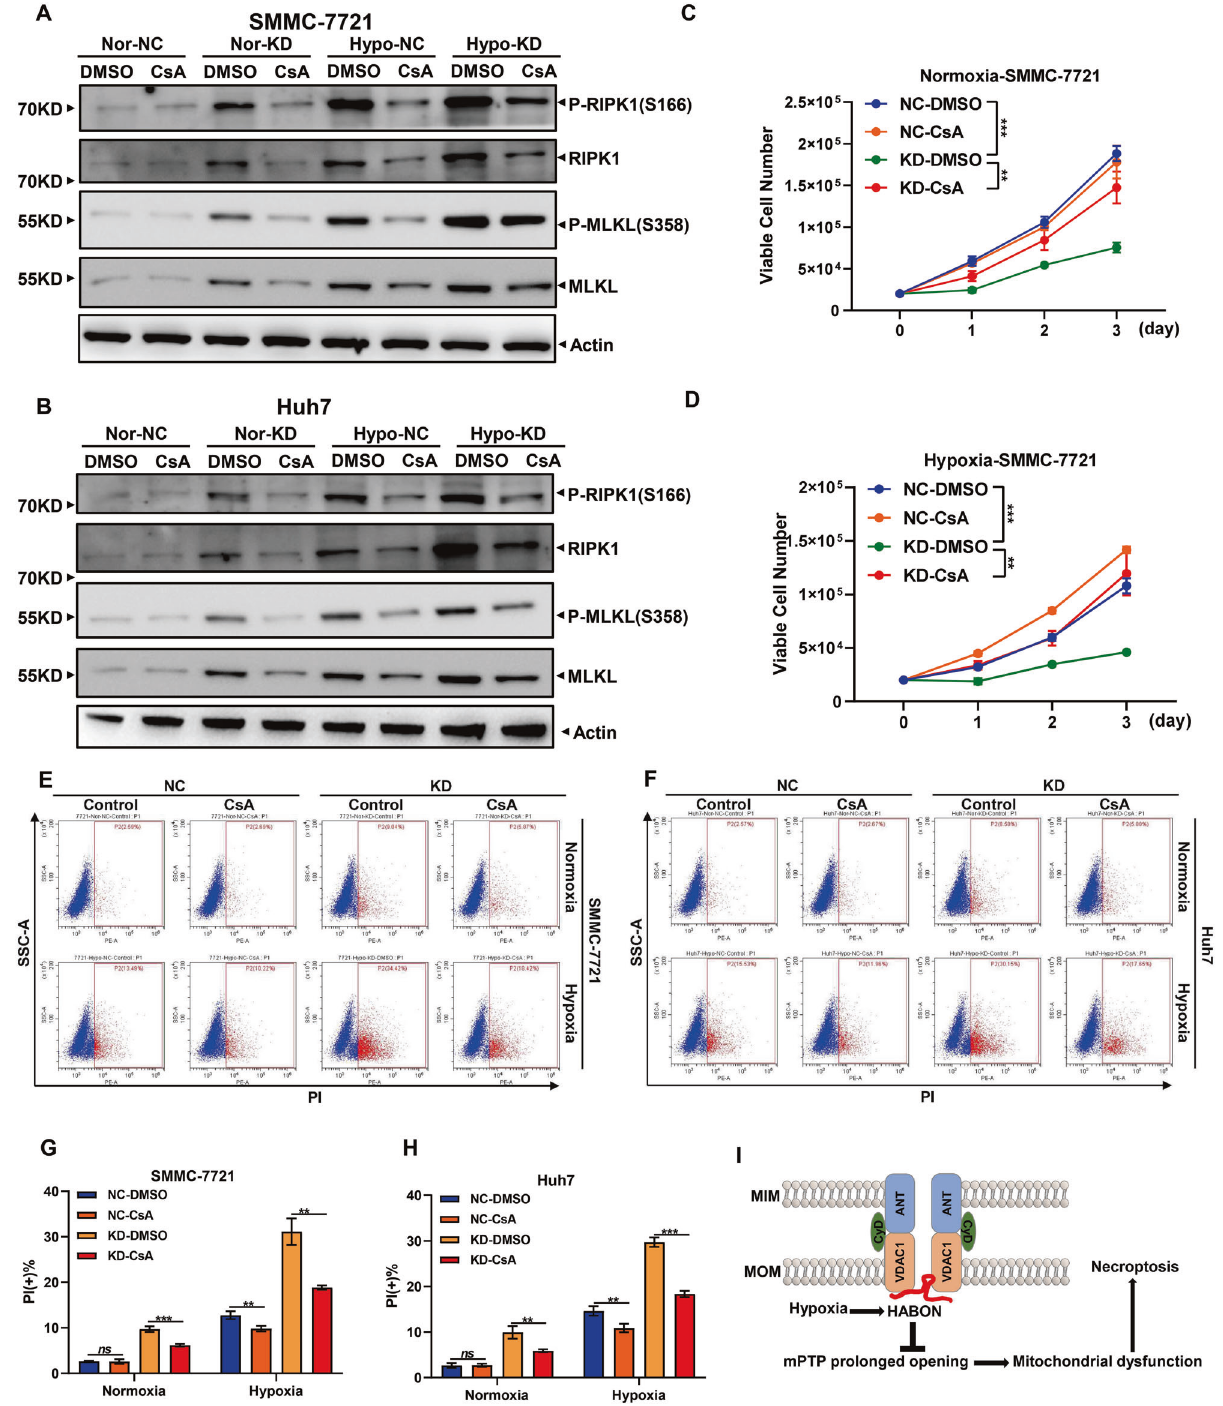
Fig. 6 Necroptosis caused from knockdown of HABON under hypoxia was mediated by mPTP opening. A , B Expression levels of necroptosis marker RIPK1, phospho-RIPK1 (Ser166), MLKL, and phospho-MLKL (Ser358) were measured by western blot following by knockdown HABON expression in liver cancer cells with or without hypoxia treatment. C , D The expression of HABON was knock-down in SMMC-7721 cells. The viable cells were measured after cultured under normoxia or hypoxia (1% O 2 ) and treated with mPTP inhibitor (5 μ M CsA) for different time. Three independent experiments, two-tailed Student ’ s t -test. E , F Flow cytometry was used to detect cell death of SMMC-771 and Huh7 cells after PI staining following treated with mPTP inhibitor (5 μ M CsA) for 24 h. The statistics of PI positive cells were shown in G , H . Error bars stand for mean ± SD. Three independent experiments, two-tailed Student ’ s t -test. * p < 0.05, ** p < 0.01, *** p < 0.001. I The mechanism schematic of HABON involved in the regulation of necroptosis induced by hypoxia.